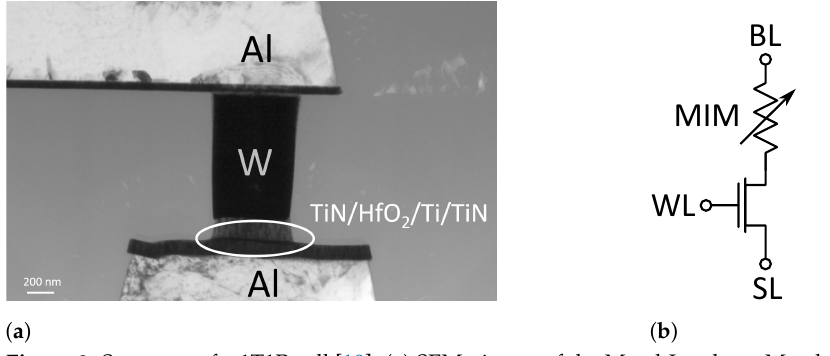
Figure 2. Structure of a 1T1R cell [10]: ( a ) SEM picture of the Metal-Insulator-Metal (MIM) stack. ( b ) Schematic representation of the 1T1R